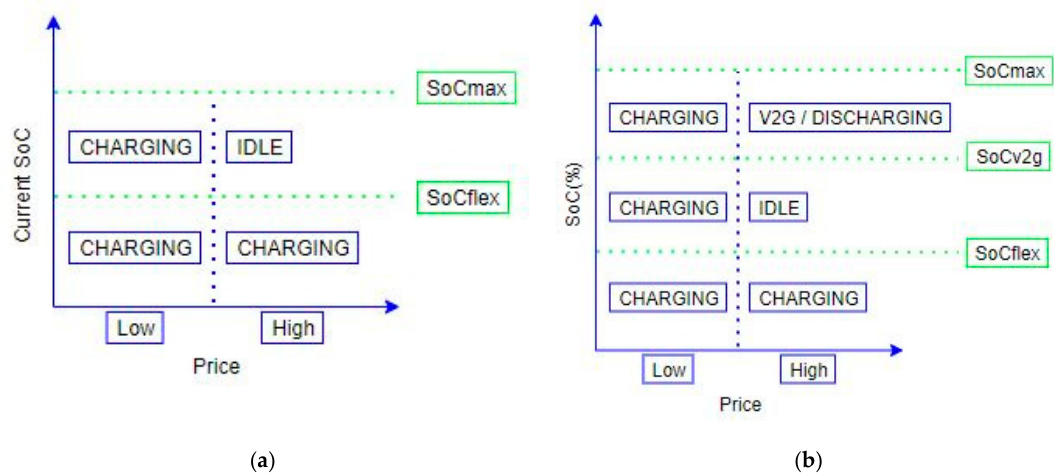
Figure 1. Charging strategy of the electric vehicle (EV) when plugged-in; ( a ) Scenario 2. ( b ) Scenario